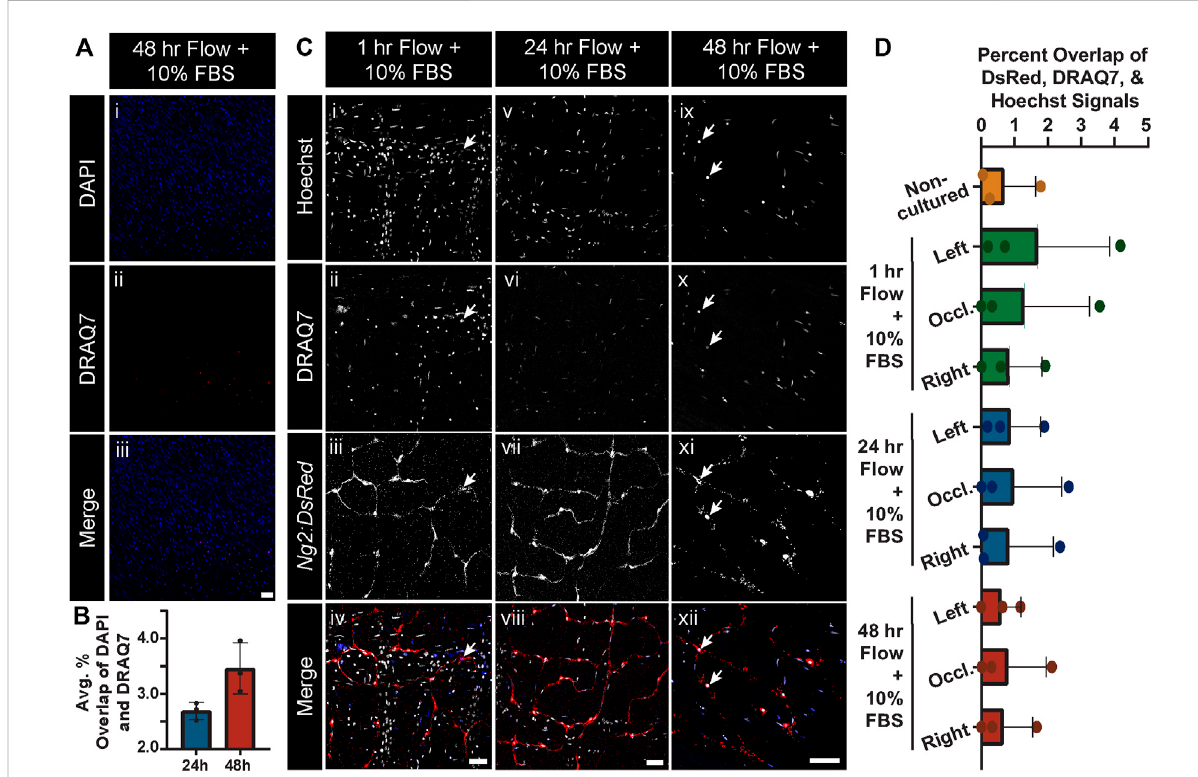
Global and Ng2:DsRed+ Cell Viability Remains Unchanged after Culture in Controlled Flow Conditions. (A) Representative images of general cell viaibility as gauged by DAPI-labeled cell nuclei (blue in i and iii) relative to compromised cell nuclei labeled with DRAQ7 (red in ii and iii) in a 48 h tissue culture with 10% FBS and controlled fl ow. Scale bar iniii is50 μ m. (B) Average percentoverlap of DAPI and DRAQ7signals across theintestinal tissueareaat24 h(bluebar)and48 h(redbar)wherecontrolled fl owwassupplied(note, y -axisrangeisfrom2%to4.5%).Errorbarsrepresent± standard deviation. Note, the live-dead staining with DRAQ7 revealed that there was not extensive cell death under the controlled fl ow and tissue culture conditions at 24 h or 48 h, despite the lack of fl ow access to most smaller-order vessels. Biological replicates for this experiment were at a minimumof n =3. (C) RepresentativeimagesofHoechst-labeledcellnuclei(i,v,ix;whiteiniv,viii,xii),DRAQ7-labeledcellnuclei(ii,vi,x;blueiniv,viii, xii),and Ng2:DsRed -labeledpericytes(iii,vii,xi;rediniv,viii,xii)intheoccludedareasof1 h(i-iv),24 h(v-viii),and48 h(ix-xii)cultureswithcontrolled fl ow. Scale bars in (iv), (viii), (xii) are 50 μ m. Note, live-dead staining with DRAQ7 revealed no notable pericyte death, even in the occluded area. Additionally, no abnormal pericyte morphology was observed. (D) Average percent overlap of DsRed, DRAQ7, and Hoechst signals across